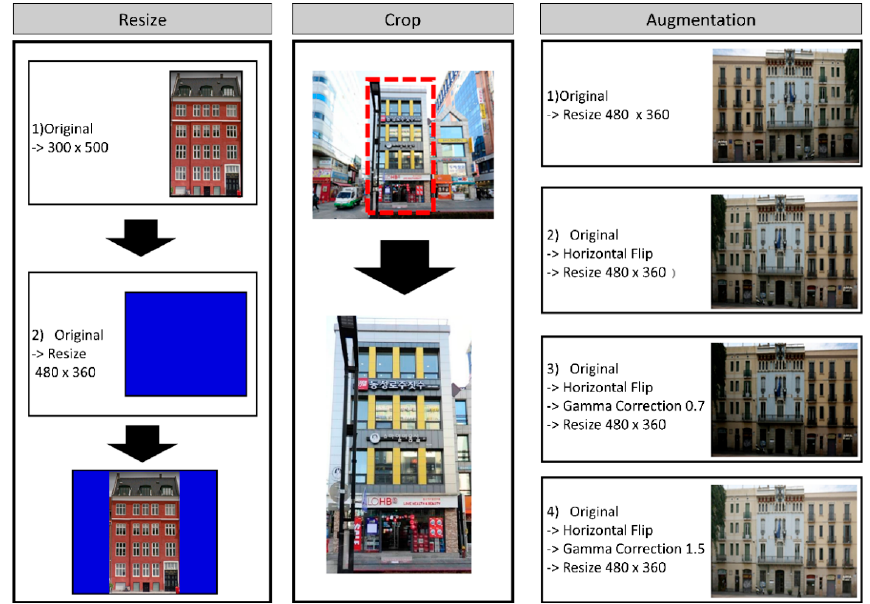
Figure 8. Optimize training data.